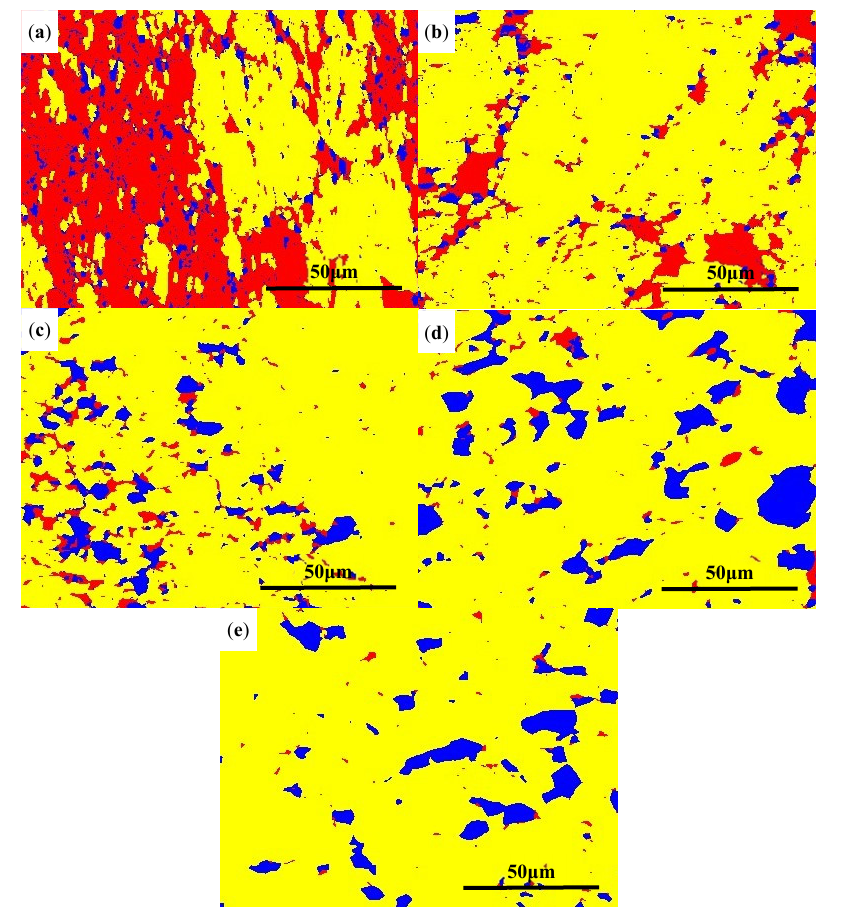
Figure 14. EBSD analysis of DRX at strain rates of 0.001 s − 1 : ( a ) 700 °C, ( b ) 730 °C, ( c ) 760 °C, ( d ) 790 °C, and ( e ) 820 °C.